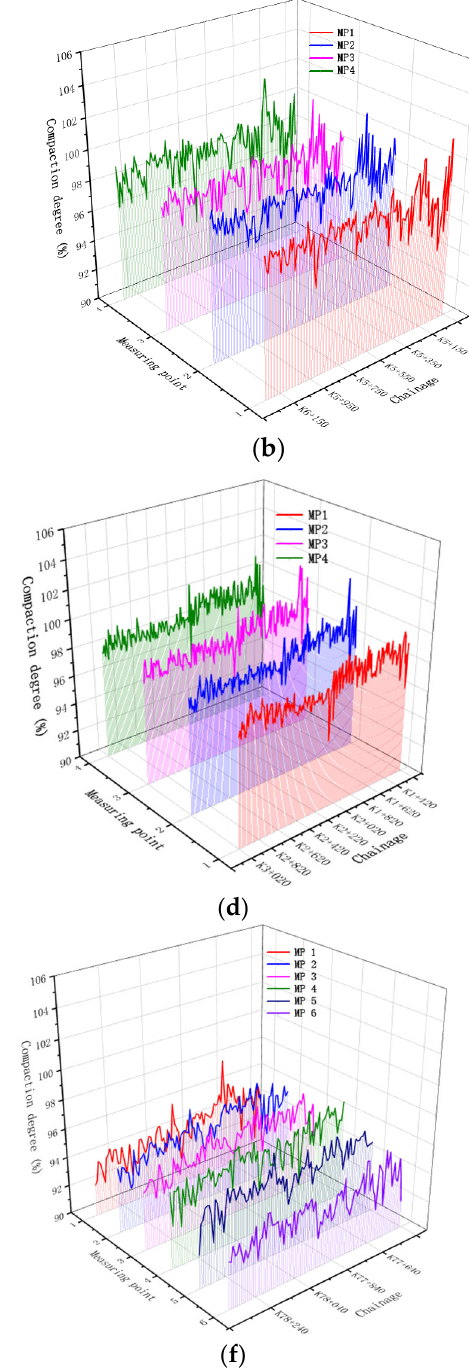
Table 4. Statistical analysis results of compaction degree.